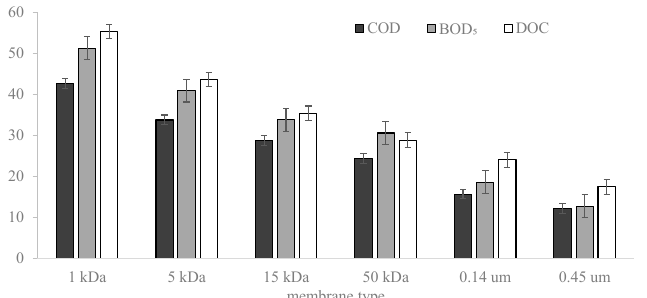
Figure 3. Effect of membrane type on the COD, BOD 5 and DOC reduction in the digestate liquid fraction using sedimentation-membrane filtration (TMP 0.3 MPa).